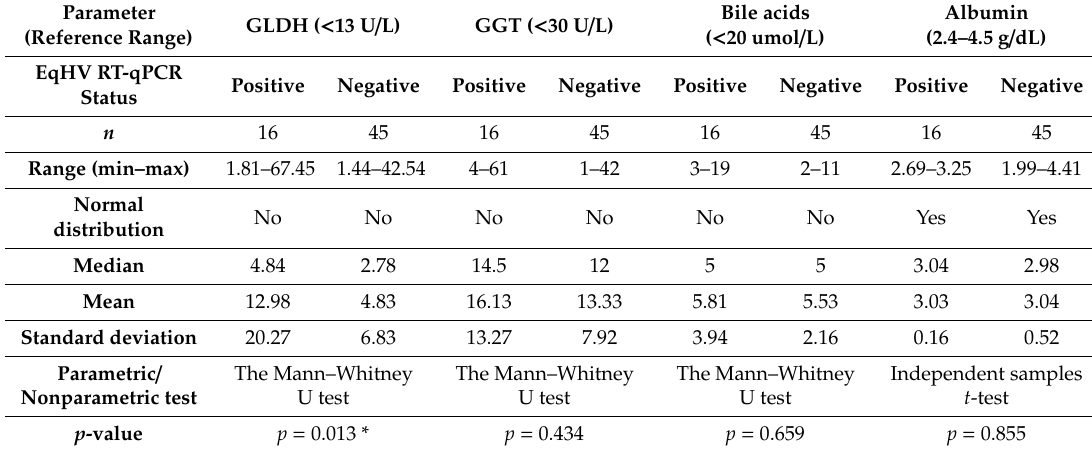
Table 2. Specifications of the liver-specific biochemistry parameters glutamate dehydrogenase